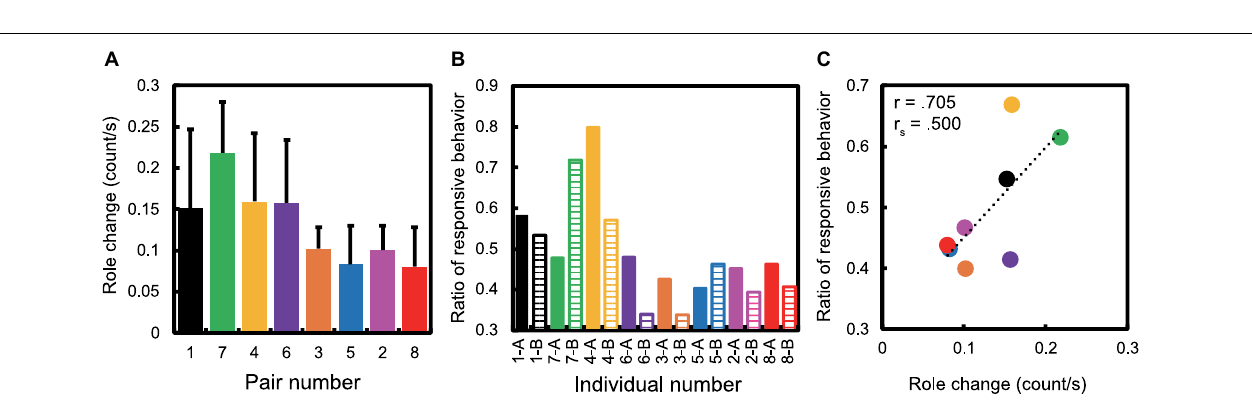
FIGURE 4 | Results of the tag games. Panel (A) shows the mean and standard deviations of X_IPDs in each pair. Panel (B) shows the mean and standard deviations of the efficiencies of individual movement for each child. Panel (C) shows the relationship between X_IPD and the mean efficiency of individual movement for each pair. * P < 0.05.